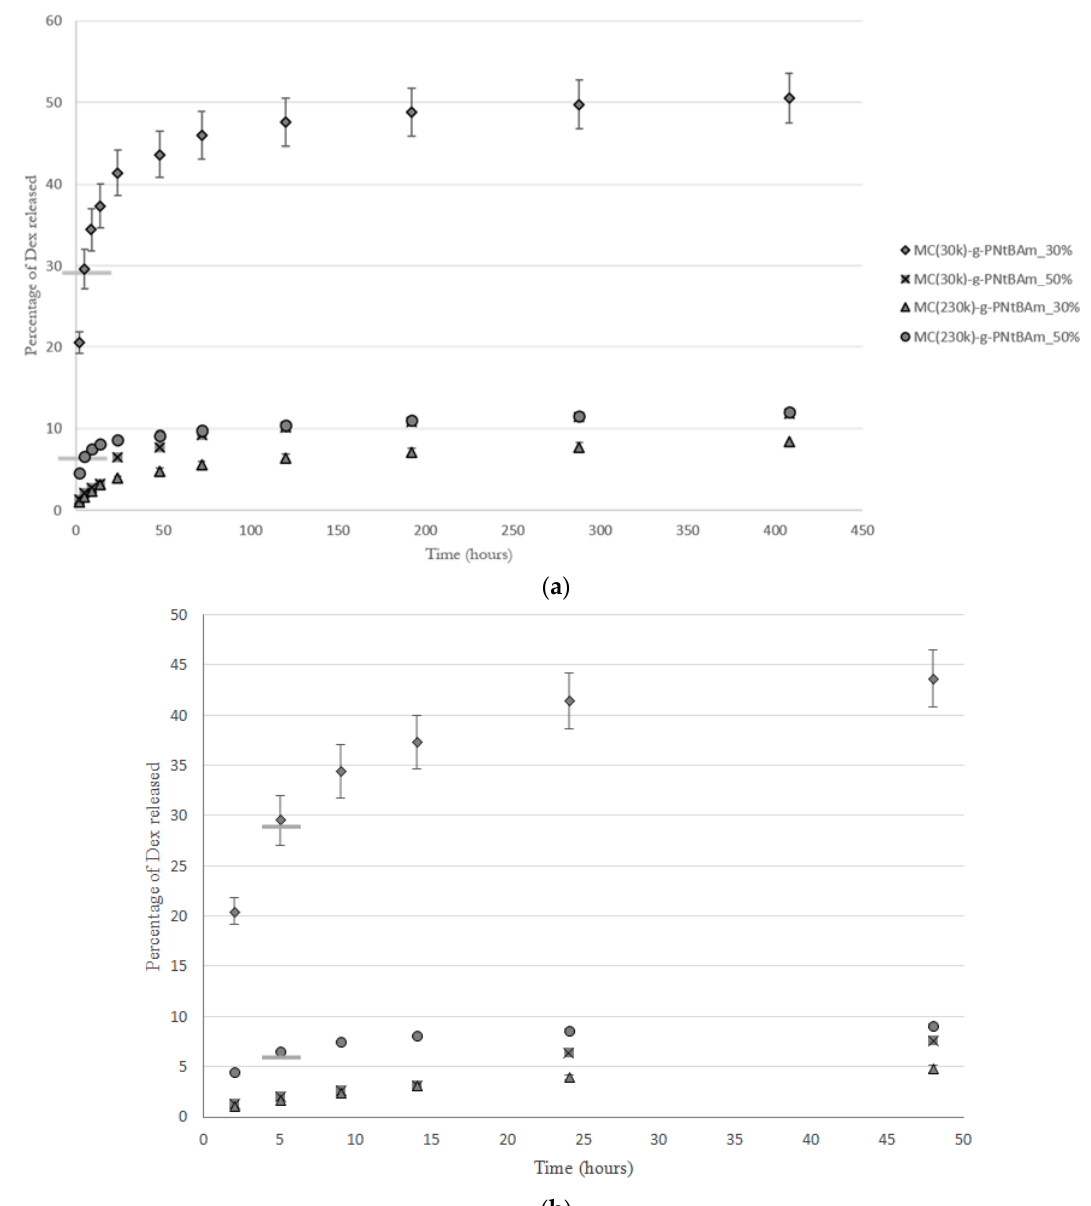
Figure 4. ( a ) Dexamethasone release from MC ‐ g ‐ PNtBAm nanogels at 30% or 50% DH and synthesized using MC of MW of 30 kg/mol or 230 kg/mol. The bars on the curves of MC(30k) ‐ g ‐ PNtBAm_30% and MC(230k) ‐ g ‐ PNtBAm_50% indicate the time point when the free drug in solution is released from the dialysis bag and the entrapped drug is being released. n = 3, with the error bars corresponding to standard deviations. ( b ) Magnification of the initial burst phase.